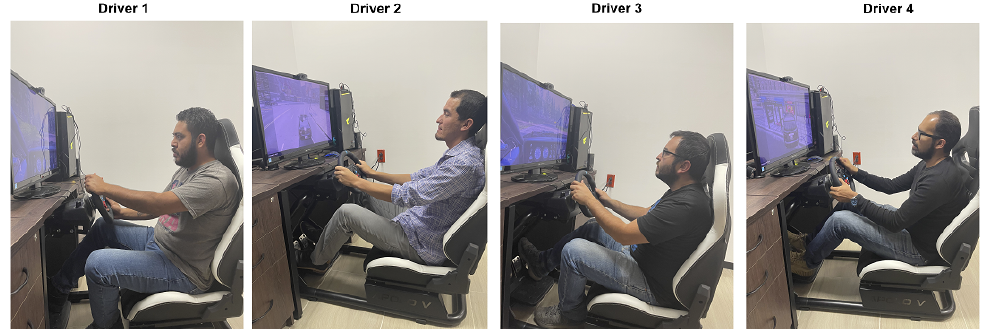
Figure 2. Study subjects performing a driving test in the laboratory of Universidad Autónoma de Zacatecas.